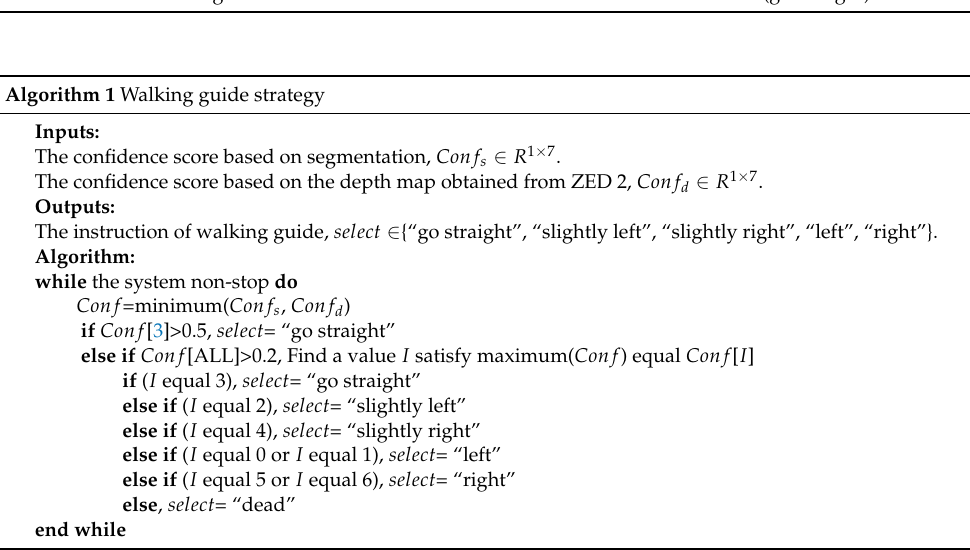
Table 4. Walking guides and voice prompts in different cases. Figure 7 Selected Division (Voice Prompt) Figure 7a dead-end, (dead) Figure 7b the third division from the left, (slightly left) Figure 7c the leftmost division, (left) Figure 7d the third division from the right (slightly right) Figure 7e the second division from the right, (right) Figure 7f The middle division (go